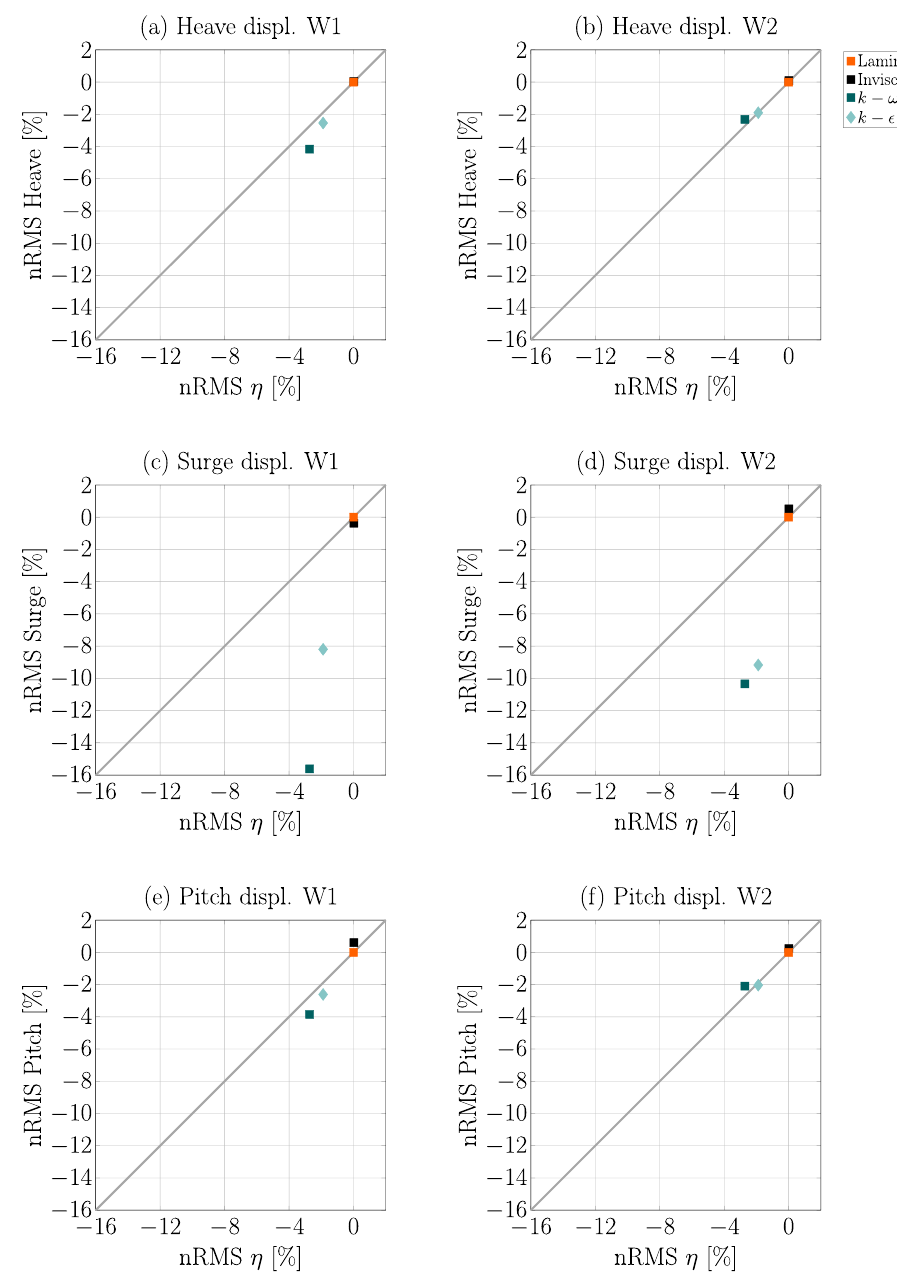
Figure 12. nRMSD of the heave, surge, and pitch displacement over the nRMSD of the free surface elevation for ( a , c , e ) W1 and ( b , d , f )